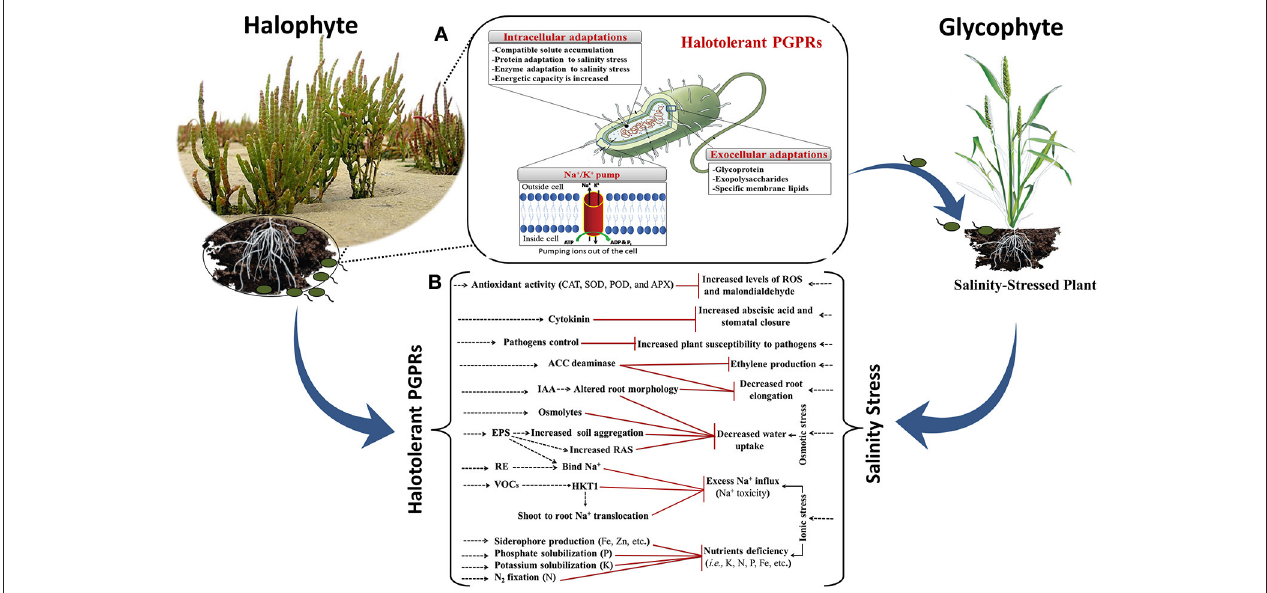
FIGURE 2 | (A) Schematic overview of the mechanisms developed by halotolerant plant growth promoting rhizobacteria (PGPRs) to live and survive in highly salinity conditions. For more details, see this reference ( Ruppel et al., 2013). (B) , Beneficial attributes of halotolerant PGPRs toward salinity stress tolerance in non-halophyte crops grown in saline soils. Red arrows indicate rhizobacterial components negating salinity stress effects. Halotolerant PGPRs increase the K + /Na + ratio by selectively enhancing K + uptake and avoiding translocation of toxic Na + under saline conditions. These bacteria are capable of increasing the antioxidative systems in plants for reactive oxygen species (ROS) scavenging such as enzymatic components of superoxide dismutase (SOD), catalase (CAT), ascorbate peroxidase (APX), peroxidase (POD), and glutathione reductase (GR) and non-enzymatic components of cysteine, glutathione and ascorbicacid. 1-aminocyclopropane-1-carboxylate (ACC)-deaminase producing PGPRs decrease the excessive ethylene production in plants caused by salinity stress and thereby eliminate the negative effect of ethylene on roots. Production of phytohormones increases the overall growth and also alters root characteristics (i.e., alteration of root proliferation, metabolism and respiration rate) to facilitate uptake of water and nutrients. Phytohormone indole-3-acetic acid (IAA) also increases the size of aerial parts of the plants. Production of osmoprotectants (i.e., proline, polyamines, glutamate, total free amino acids, etc.) by PGPR also contributes to salinity stress tolerance in PGPRs-inoculated